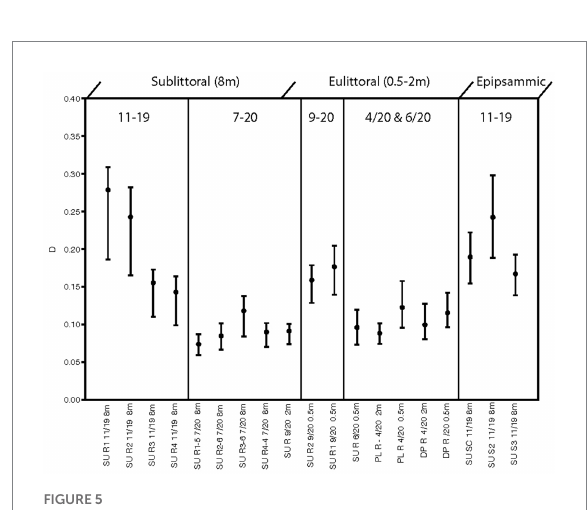
FIGURE 5 Plot of species dominance, D in enumerated diatom